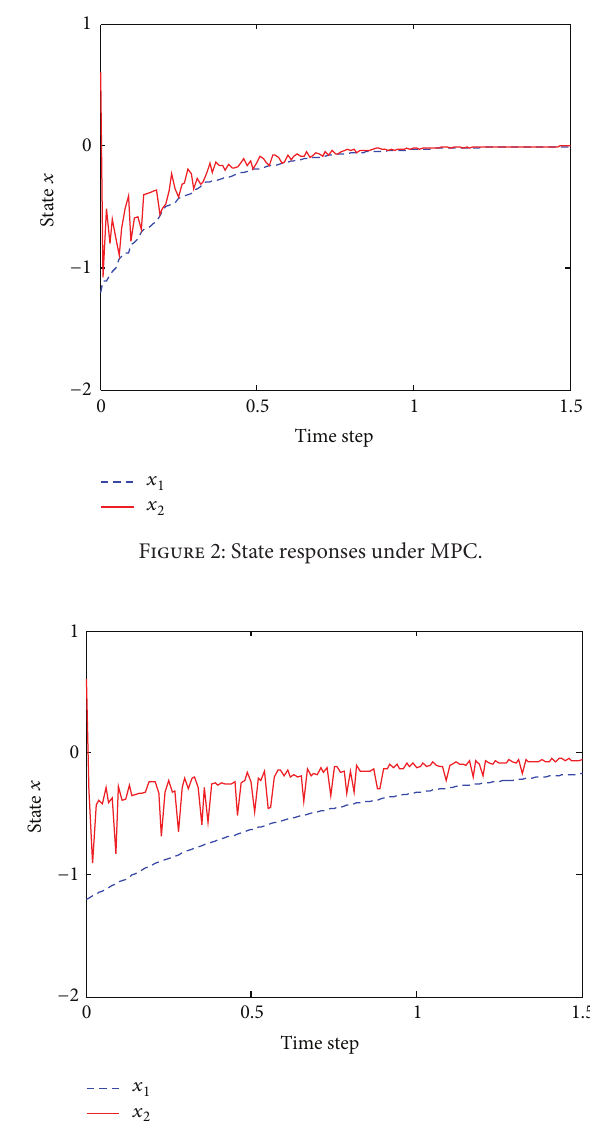
Figure 3: State responses under normal state feedback